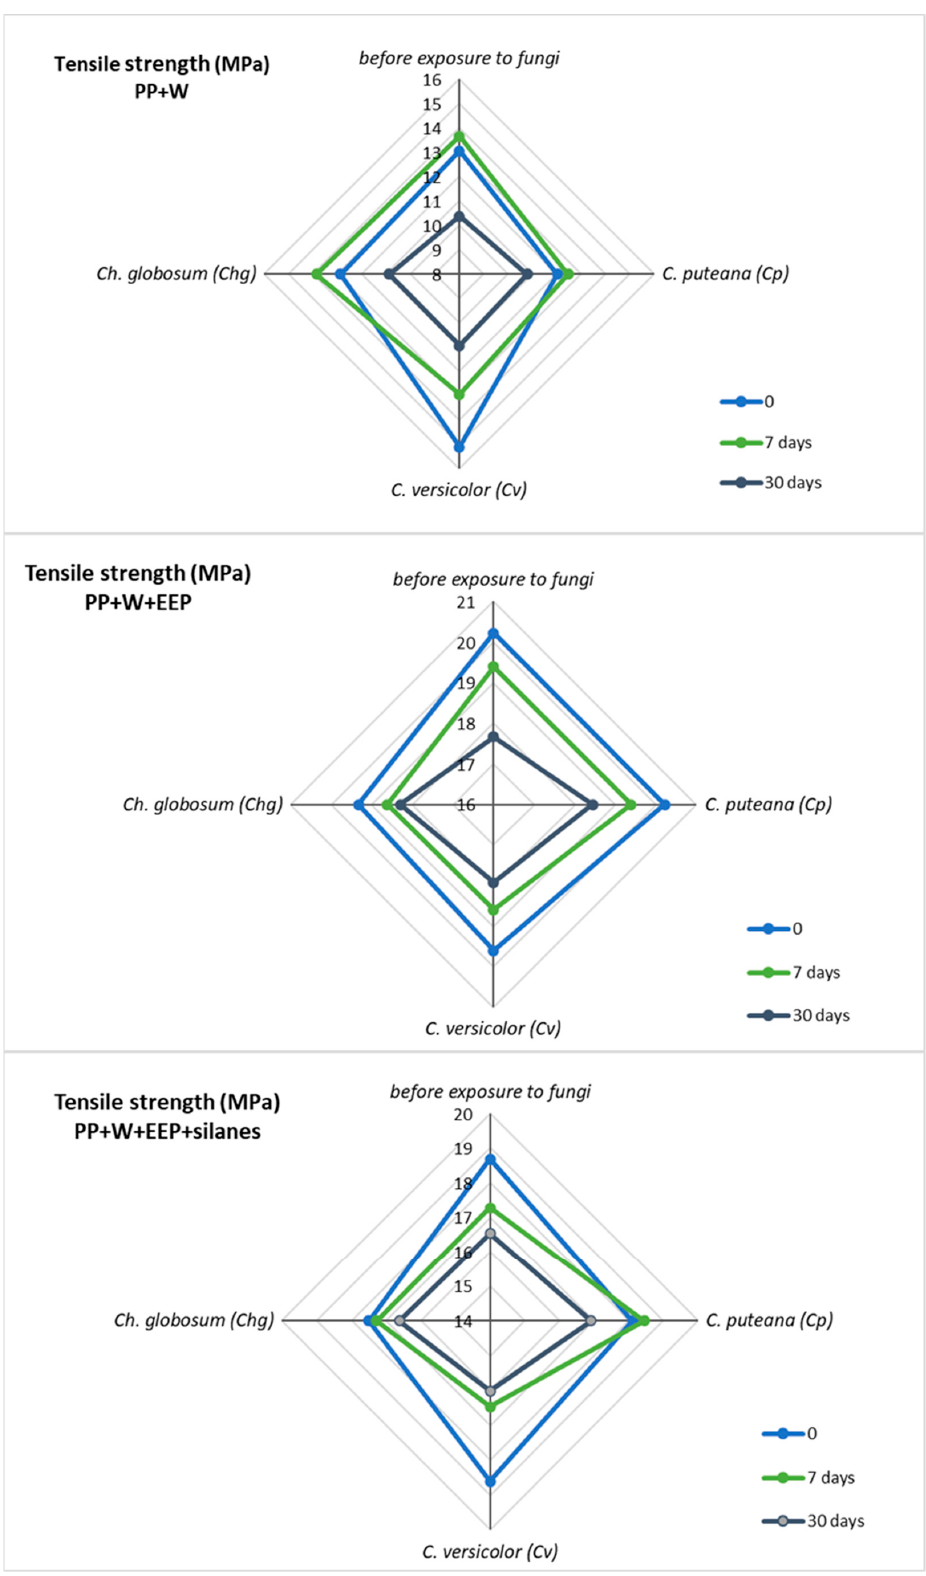
Figure 9. Young’s modulus of composites before and after UV radiation and fungal action.